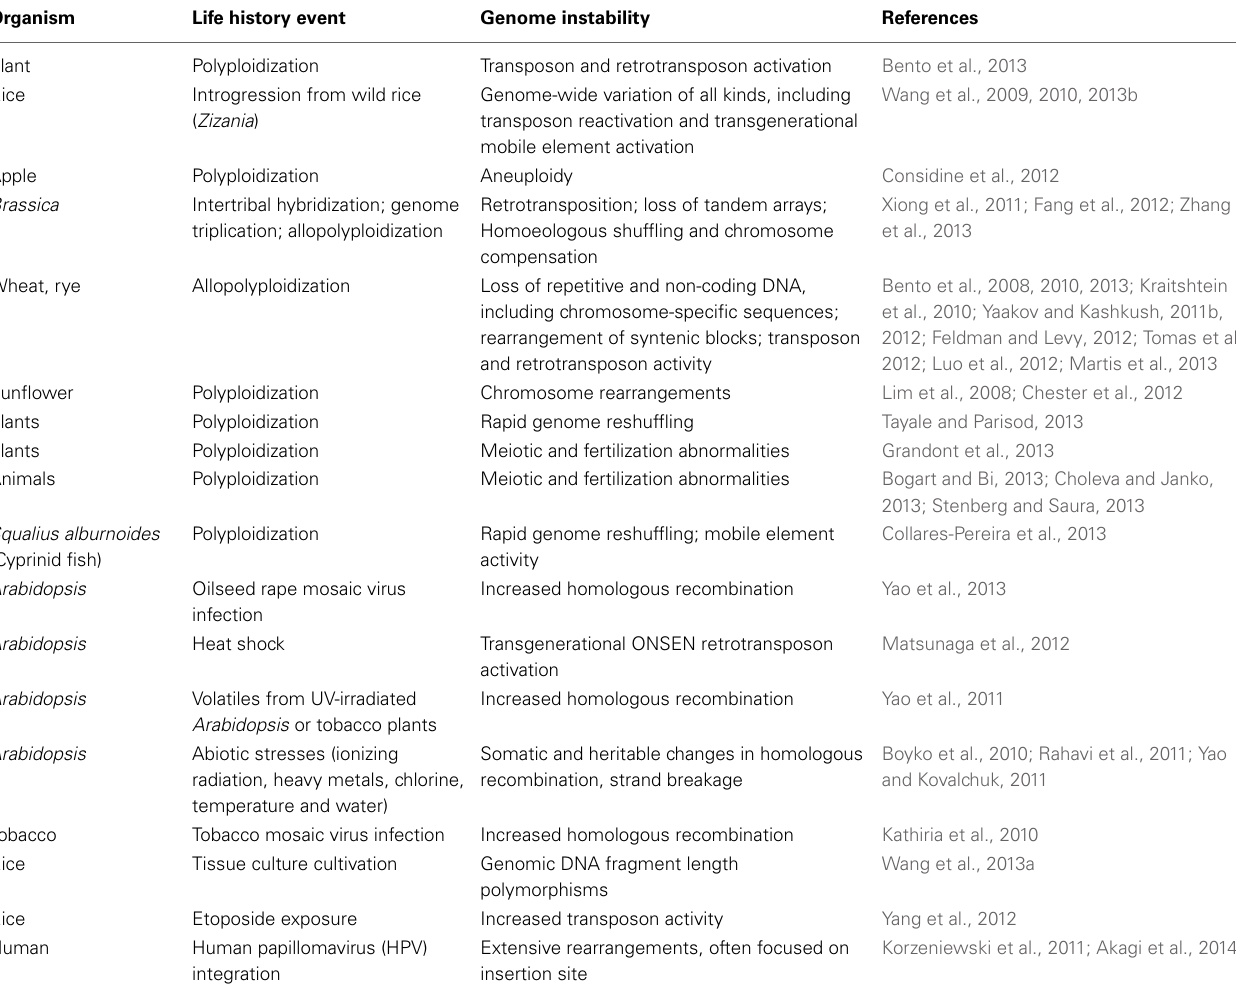
Table 2 | Life history events that lead to genome destabilization (see also http://shapiro.bsd.uchicago.edu/TableII.8.shtml for earlier